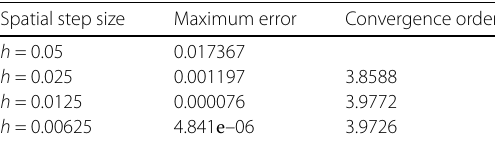
Table 9 The convergence order for R-CFDS4 at τ = 0.0025 Spatial step